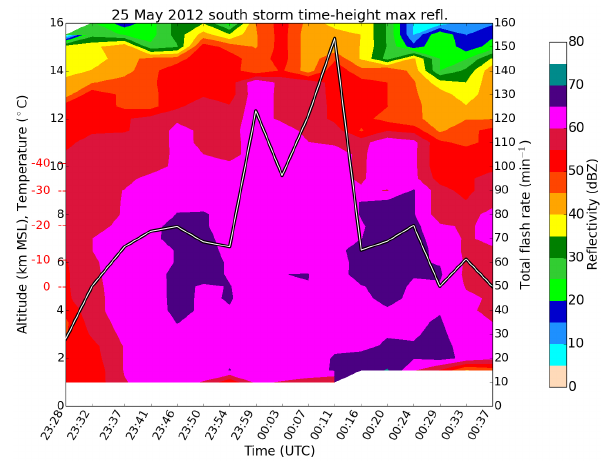
Figure 14. As in Fig. 6, but for the 25–26 May 2012 southern (stronger)